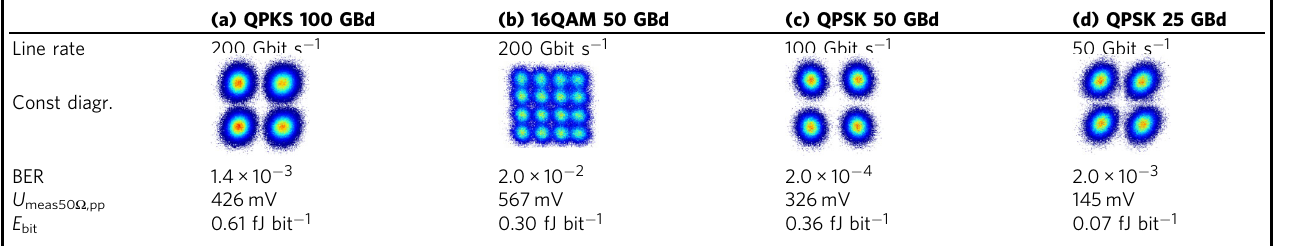
Constellation diagrams and sub-fJ bit − 1 electrical energy consumptions at (a) 100 GBd, (b, c) 50 GBd, and at (d) 25 GBd